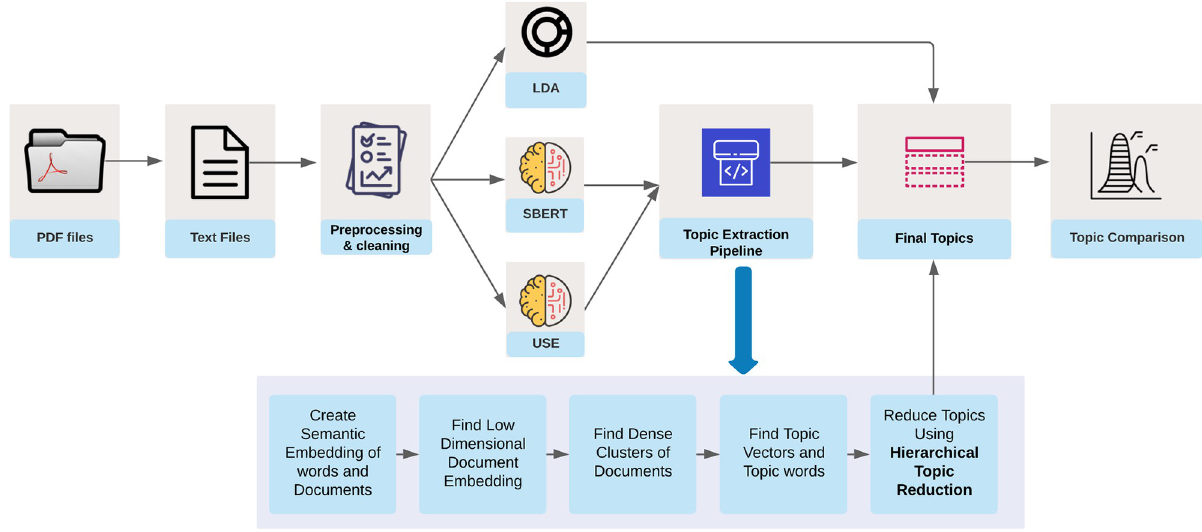
Fig 1. Topic modelling framework for comparison of the Upanishads with the Bhagavad Gita.